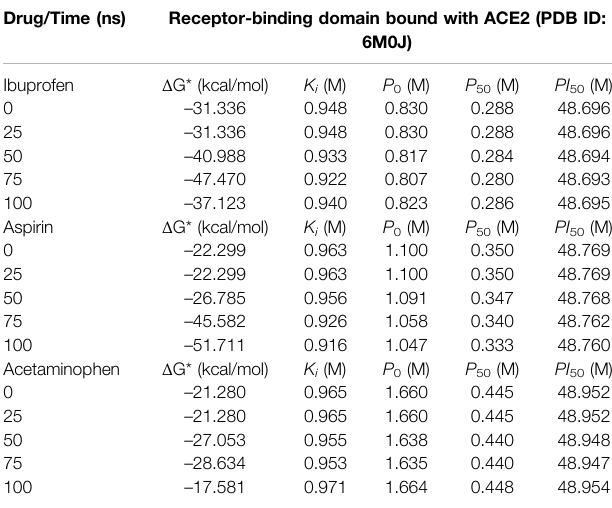
*Gibbs free energy of binding derived from the thermodynamic mean of all the binding energies considered in this study; Ki, inhibition constant derived from the dissociation constant of the AutoDock algorithm; P0, global free protein amount of the complex equivalent to 0% inhibition; P50, global free protein amount of the complex equivalent to 50% inhibition; PI50, free protein amount of ACE2 (considered as the enzyme) and RBD (consideredastheinhibitor)equivalentto50%inhibition.ForthesecalculationstheIC50- to-Ki web tool was used.